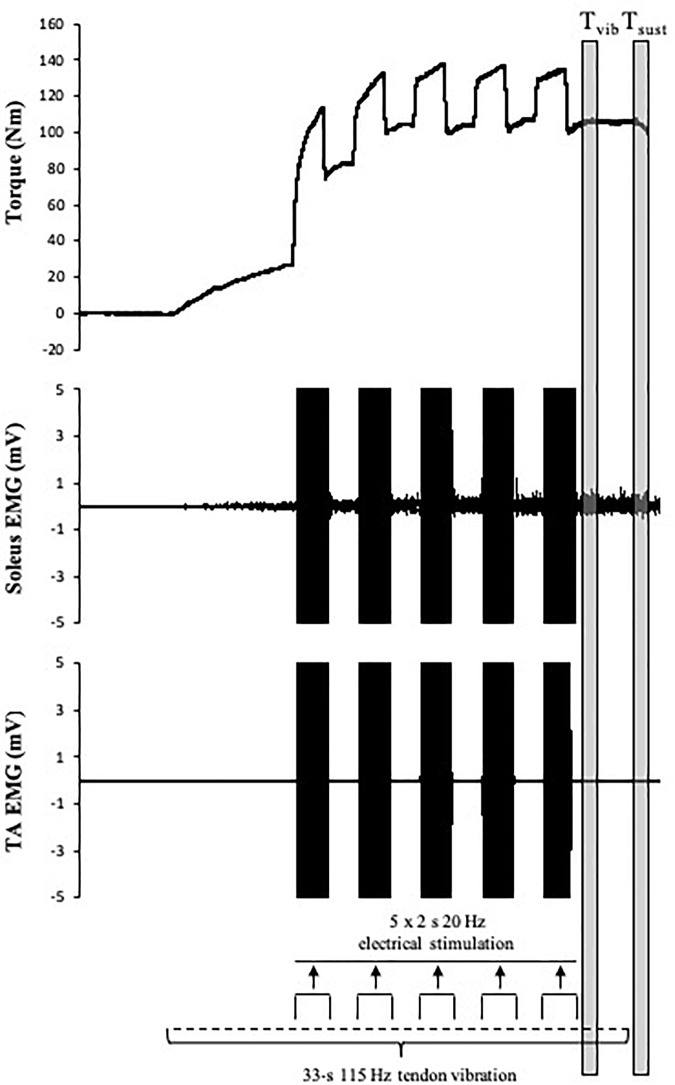
Schematic representation of the tendon vibration and superimposed tibial nerve stimulation protocol used to elicit reflexive muscular contractions and the respective time points at which torque was recorded. Tvib, torque is measured after the fifth (last) bout of electrical stimulation; Tsust, torque is measured 500 ms after vibration cessation (self-sustained torque). EMG trace indicates pronounced SOL but minimal TA muscle activity throughout the VIB+STIM sequence.